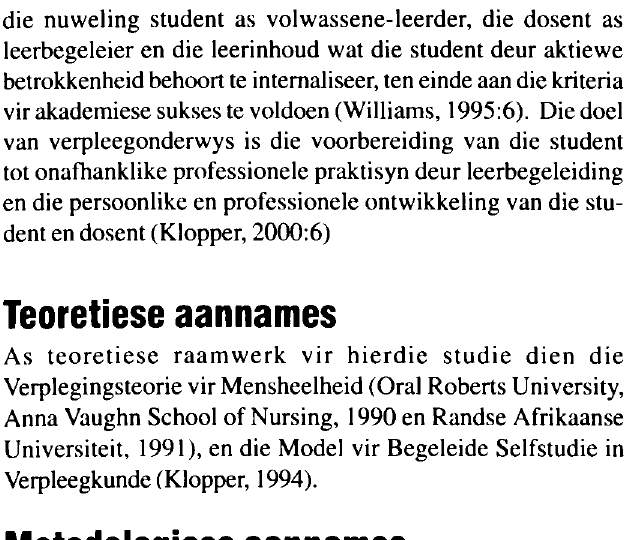
fokusgroepbespreking het die fasiliteerder veldnotas